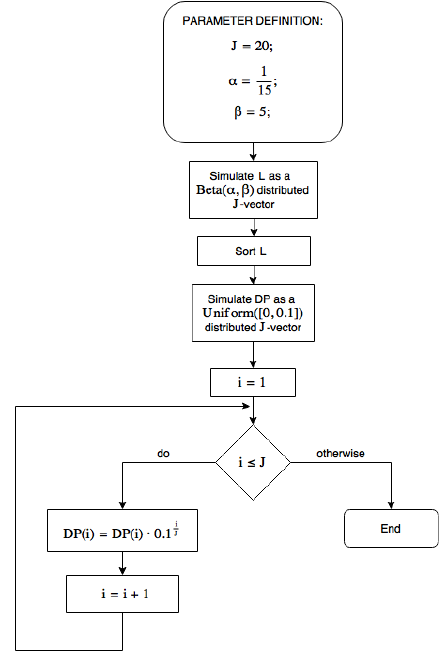
Figure 2: Loss and Default Probability simulation.